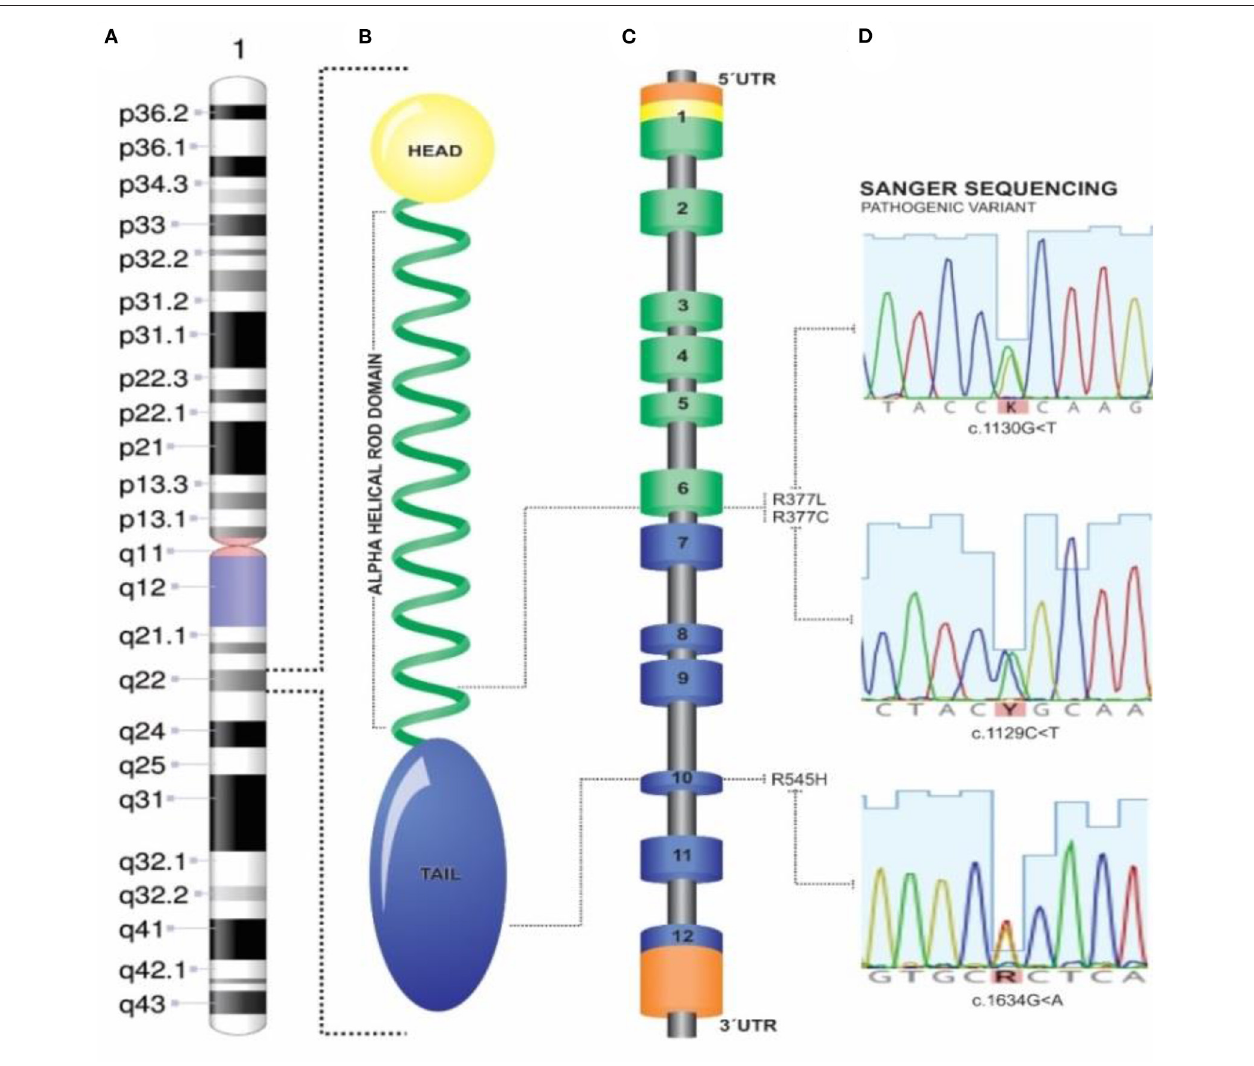
FIGURE 1 | Lamin structure and genetic findings. (A) Chromosome 1 and 1q22 LMNA locus; (B) Head-rod-tail domain LMNA structure; (C) Schematic LMNA gene and 5 ′ -3 ′ exome. (D) Sanger sequences and exon position of variants found. linear dimension of the left atrial, and pulmonary hypertension (PASP = 47 mmHg). She had no documented